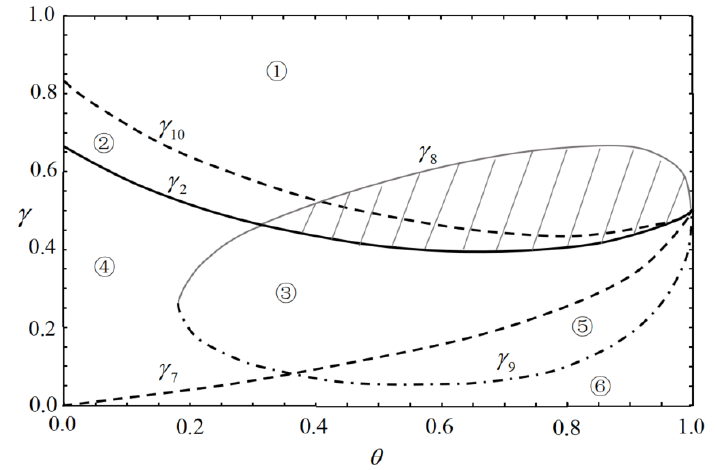
Figure 6. The   area